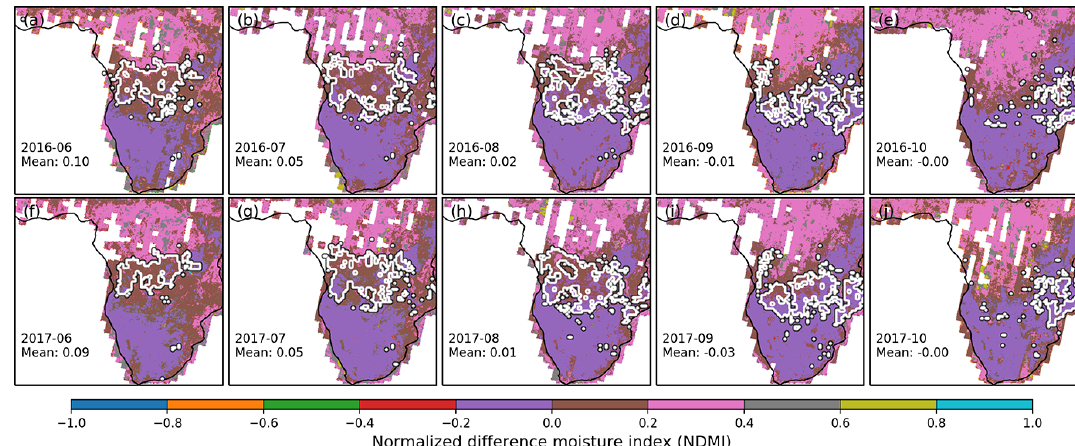
Figure 10. Major burning locations and normalized difference moisture index (NDMI) during the BB season in 2016 and 2017. Areas with an accumulated fire count greater than 500 are illustrated in the black contour in each month, and are defined as the major burning areas. The mean values of NDMI in the major burning areas each month are also displayed in the figure.